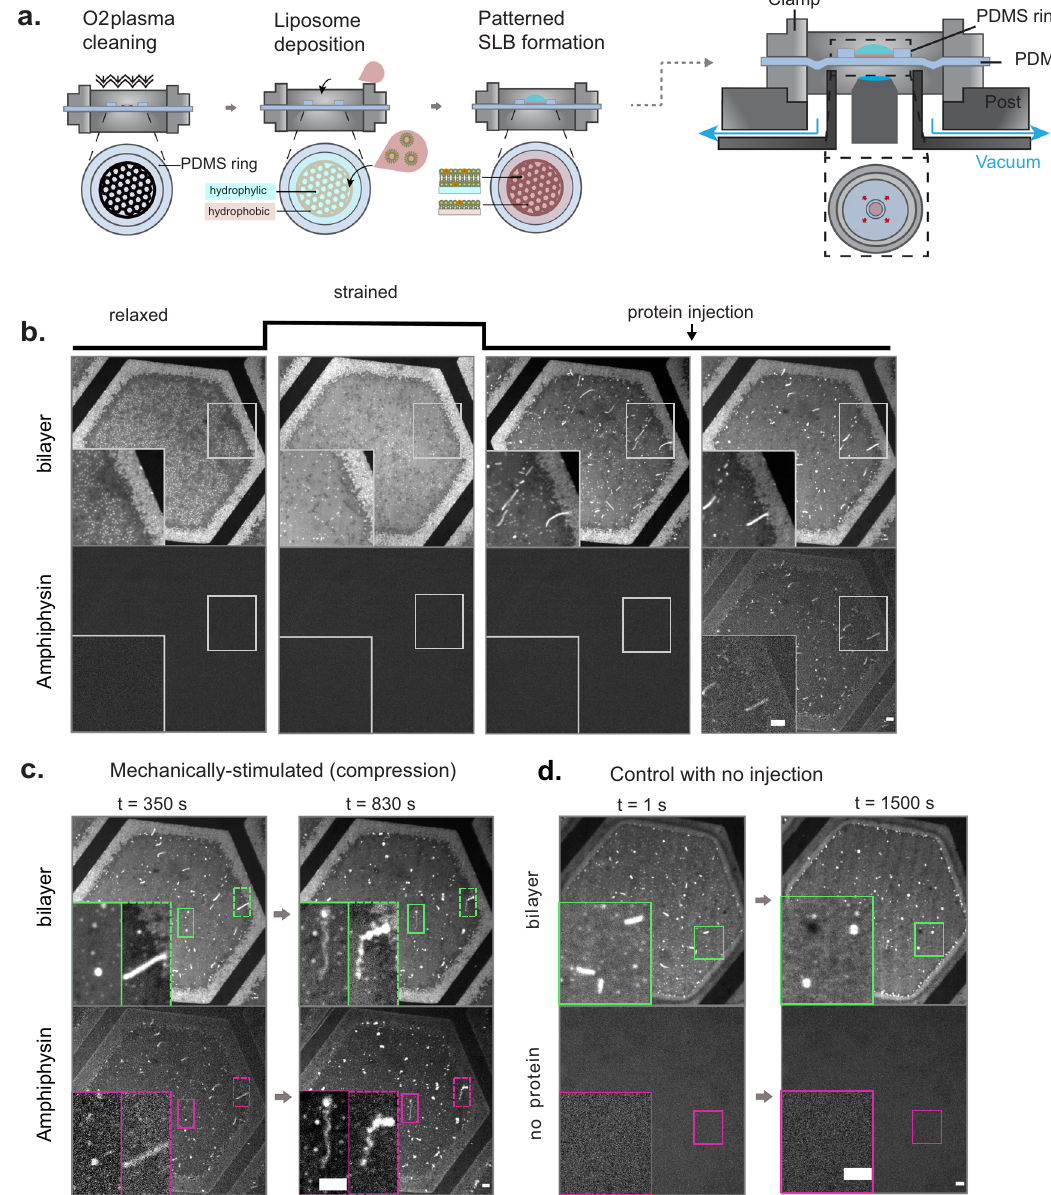
Fig. 1 Experimental system. a Schematics of the patterned supported lipid bilayer (pSLB) placed in a stretch system compatible with confocal microscopy. The pSLB is obtained by plasma cleaning a PDMS membrane in presence of a TEM grid. Only the exposed PDMS becomes hydrophilic, and subsequent liposome deposition renders a SLB after buffer rinse. The non-exposed PDMS remains hydrophobic and a lipid monolayer is formed instead. b Representative images of the mechanical stimulation of the pSLB, showing both lipid and protein fl uorescence images. In the resting initial state, excess liposomes stand on top of the pSLB. With strain, the liposomes incorporate in the pSLB. Upon release, excess lipids are expelled in the form or tubes or buds. At this stage, fl uorescent Amphiphysin is gently microinjected on top of pSLB and its binding to the tubes and buds is monitored with time. c Membrane tubes (green inset) and buds (purple inset) before (left) and after (right) being reshaped by Amphiphysin. d Control in which no protein is injected on top of the pSLB. Scale bar, 5 μ